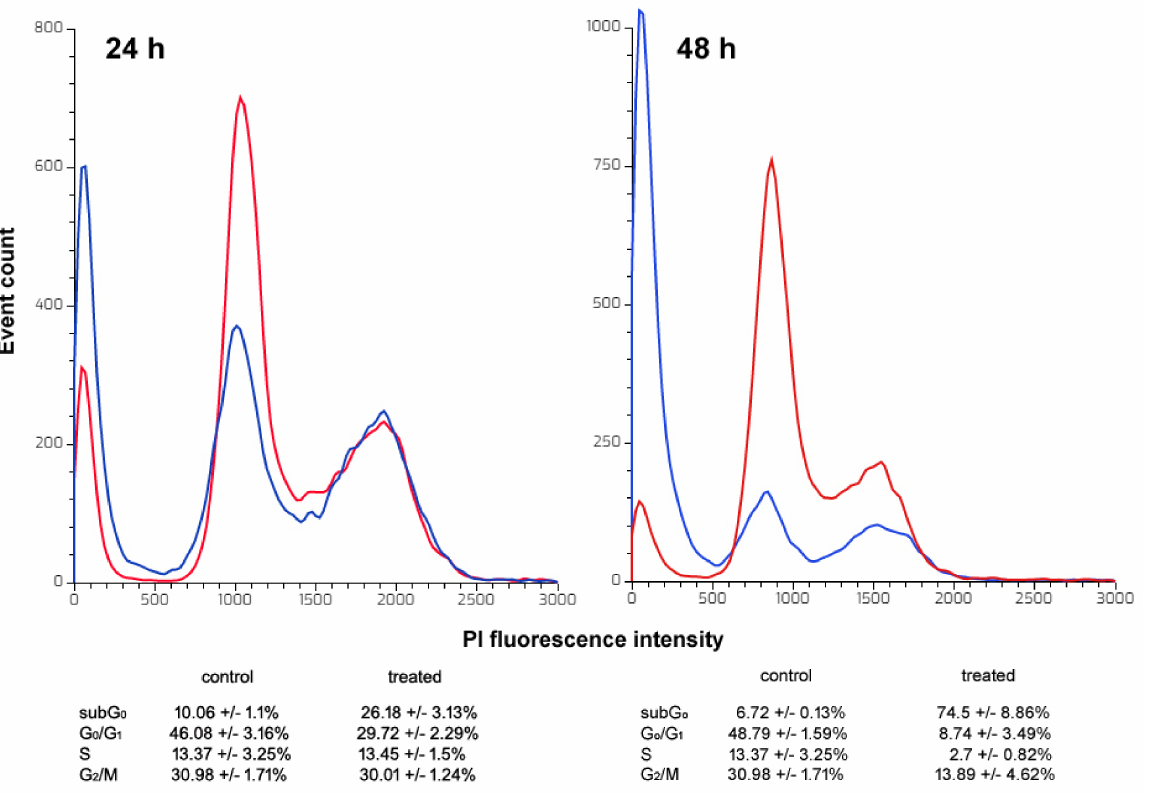
Figure 3. Representative DNA profiles of control (red line) and CFE-treated (blue line) HepG2 cells after 24 and 48 h of exposure. The cell population distribution in the cycle phases in triplicate experiments is reported in the annexed panels as the mean ±